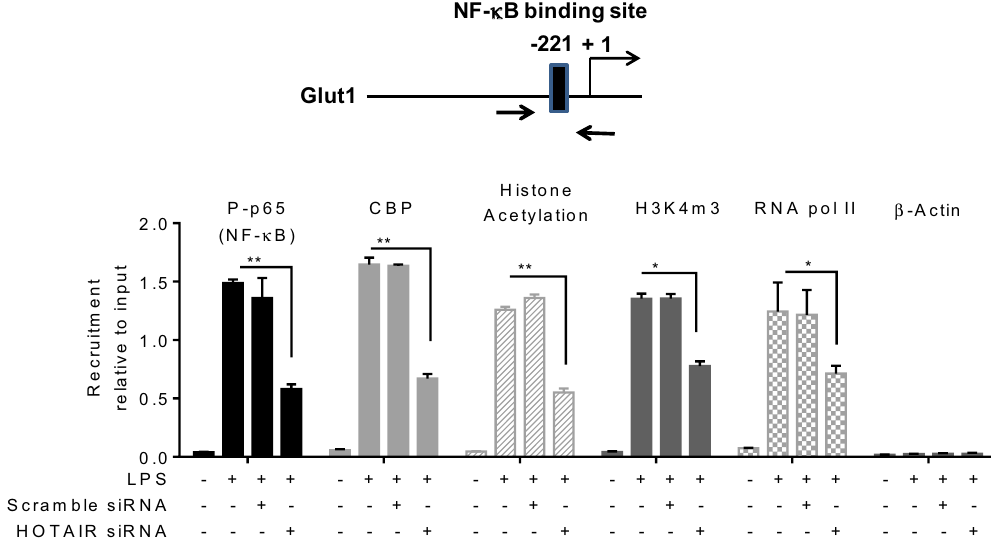
Figure 4. Knockdown of HOTAIR reduces the LPS-dependent recruitment of NF-κB on Glut1 promoter. RAW264.7 macrophage cells were transfected with HOTAIR and scramble-siRNA, then treated with LPS (1.5 h). Cells were then fixed with formaldehyde and subjected to ChIP assay using antibodies specific to phospho-p65, CBP, histone acetylation, H3K4m3, RNA pol II and β-actin (control). The immunoprecipitated DNA fragments were analyzed by qPCR using primers specific to the NF-κB binding regions on Glut1 promoter. The location of NF-κB binding site at the Glut1 promoter is shown in the top panel. Each experiment was repeated at least thrice (n = 3). Data represent mean ± SD; *p < 0.05, **p < 0.001.